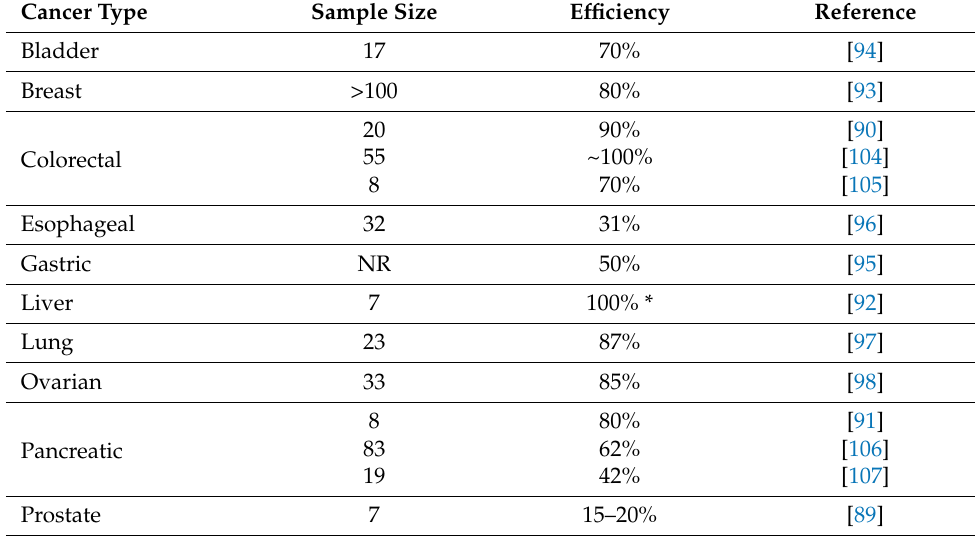
Table 3. Success rates for PDO